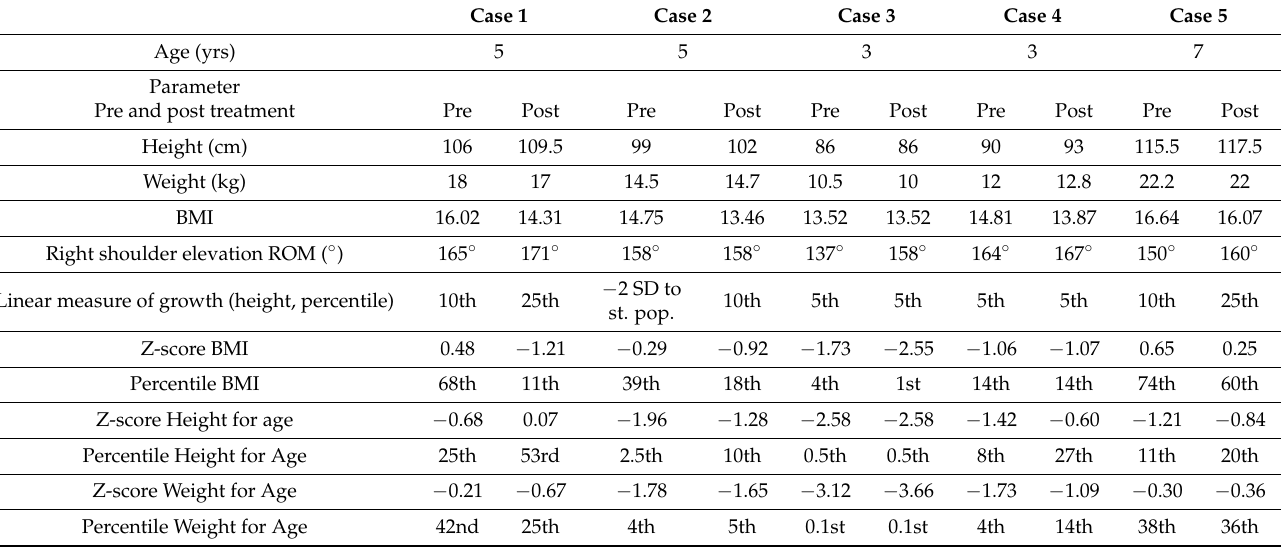
Table 1. Synthesis of the biometric values for all the cases